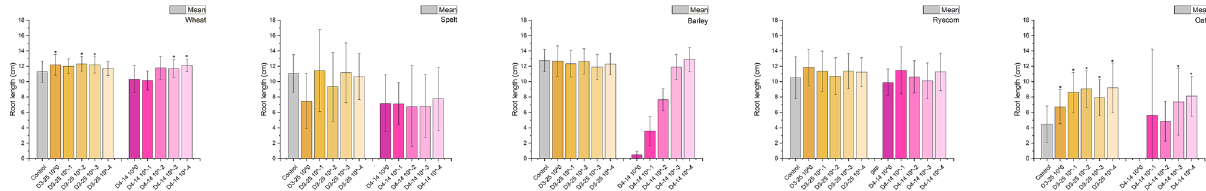
Figure 5. Biostimulation effects of Cf D3-25 or Ar . sp D4-14 in roots of Triticeae species. Root length (cm) of wheat, barley, oat, ryecorn and spelt seedlings inoculated with different concentrations (10 0 , 10 –1 , 10 –2 , 10 –3 and 10 –4 ) of Cf D3-25 or Ar . sp D4-14 (ANOVA, P < 0.05). Stars indicate inoculum concentrations that had significantly longer roots. Error bars show standard